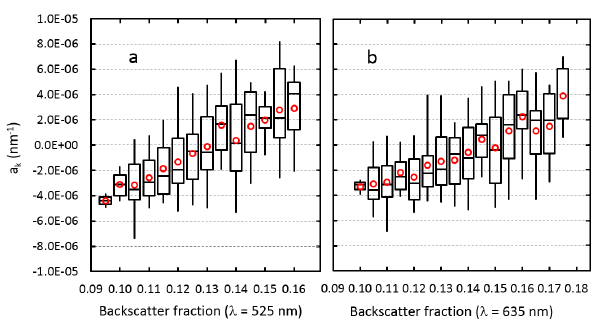
Figure 7. Daily averaged slope ( a k ) of the compensation parame- ter classified into 0.005 wide bins of the backscatter fraction of (a) green ( λ = 525nm) and (b) red ( λ = 635nm) light. The box plots present the 5th, 25th, 50th, 75th, and 95th percentiles and the cir- cles the averages in each bin.